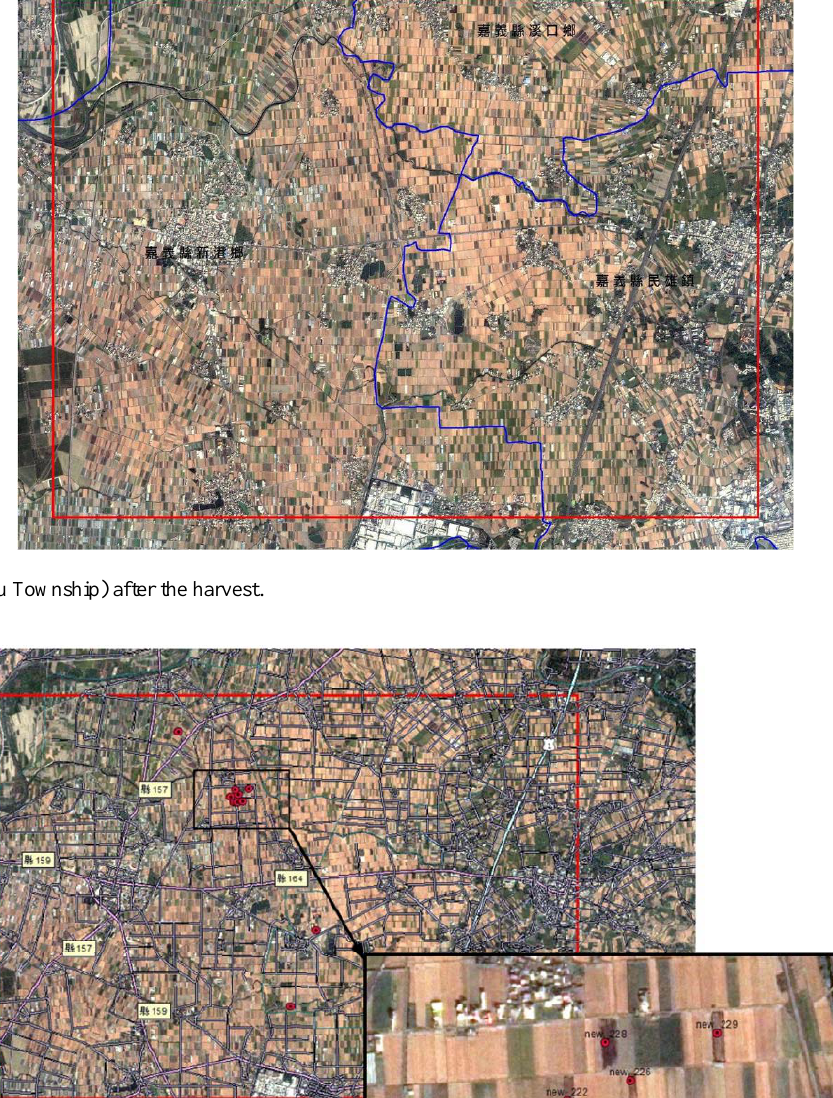
Table 1 Statistics for classification of study area